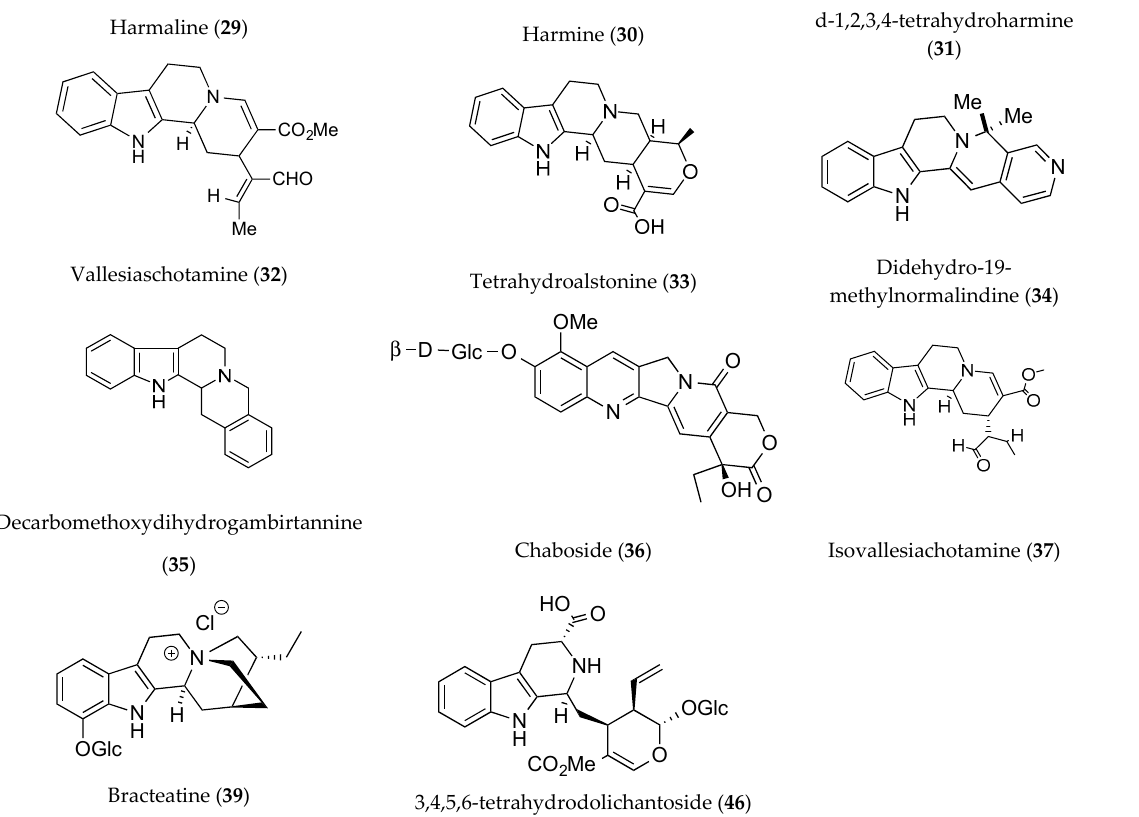
Figure 3. Alkaloids from the genus of Ophiorrhiza. *Glc = glucose molecule.